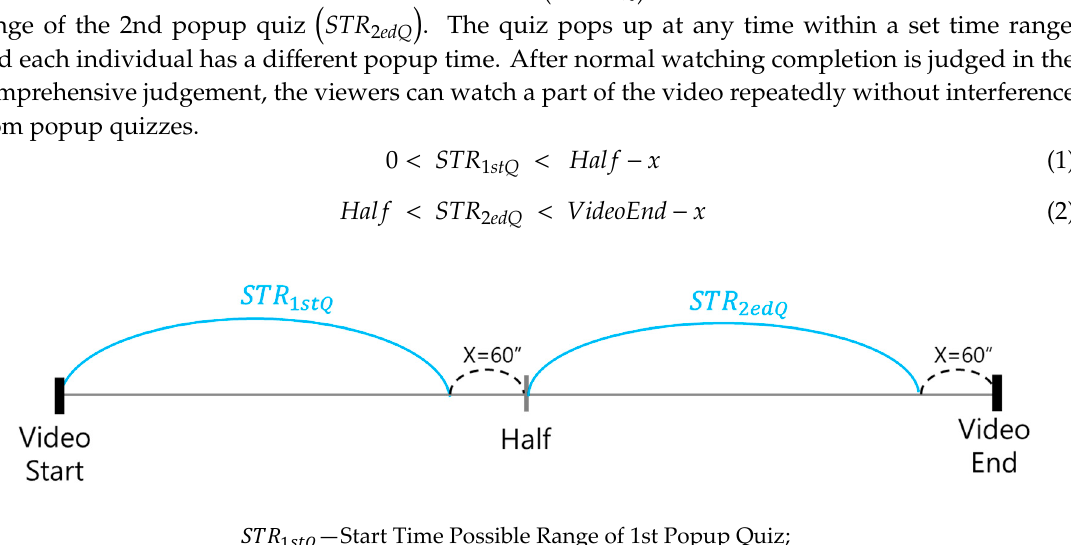
Figure 4. Process of Time Interval Pass.